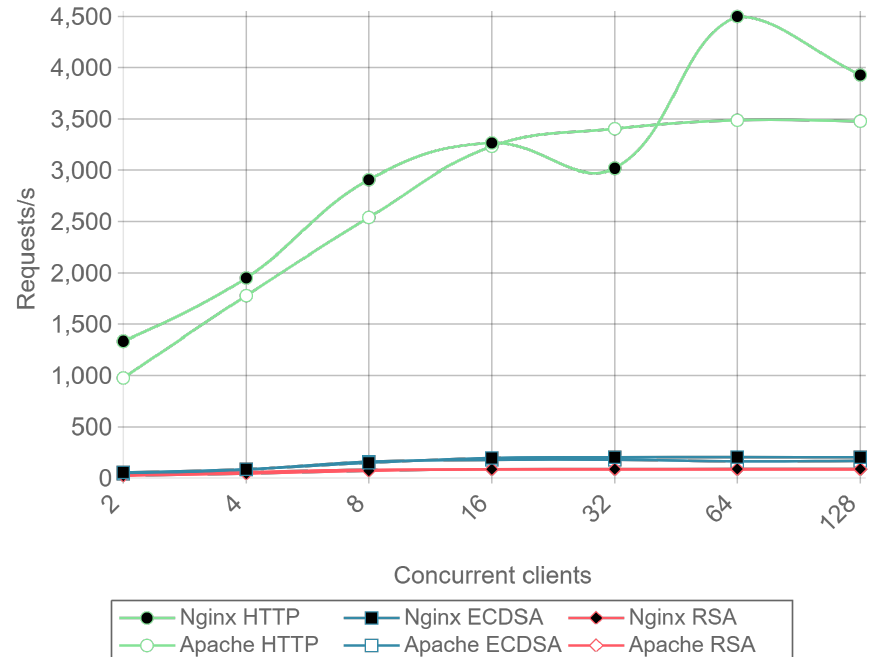
Figure 13. Server-side concurrent clients versus throughput for Apache2 and Nginx with 512 bytes of payload for Elliptic Curve Digital Signature Algorithm (ECDSA), Rivest–Shamir–Adleman (RSA), and